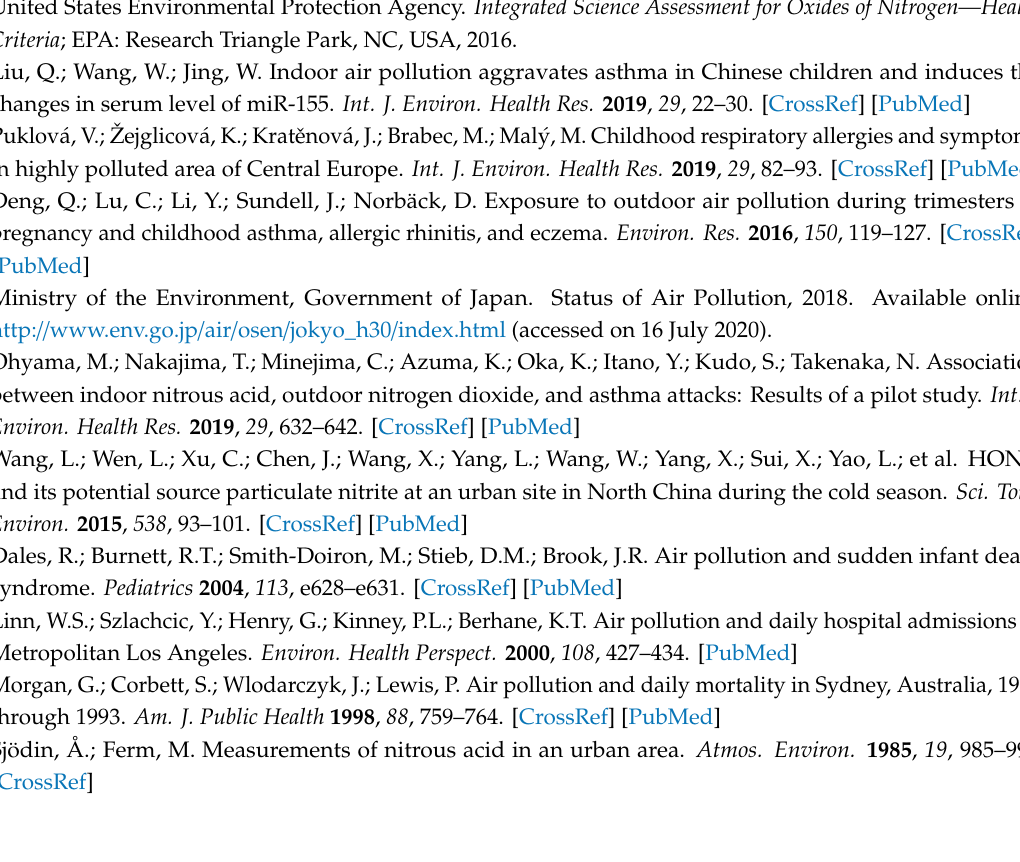
Table S1: The numbers of missingness of hourly and daily data by the compounds and air pollution monitoring stations; Table S2: Climate and air pollution factors associated with NO 2 concentration in the atmosphere from SARIMAX models at AAPMSs in Tokyo, Aichi, Osaka, and Yamanashi Prefectures, Japan; Table S3: Climate and air pollution factors associated with NO 2 concentration in the atmosphere from SARIMAX models at RAPMS in Tokyo, Aichi, Osaka, and Yamanashi Prefectures,